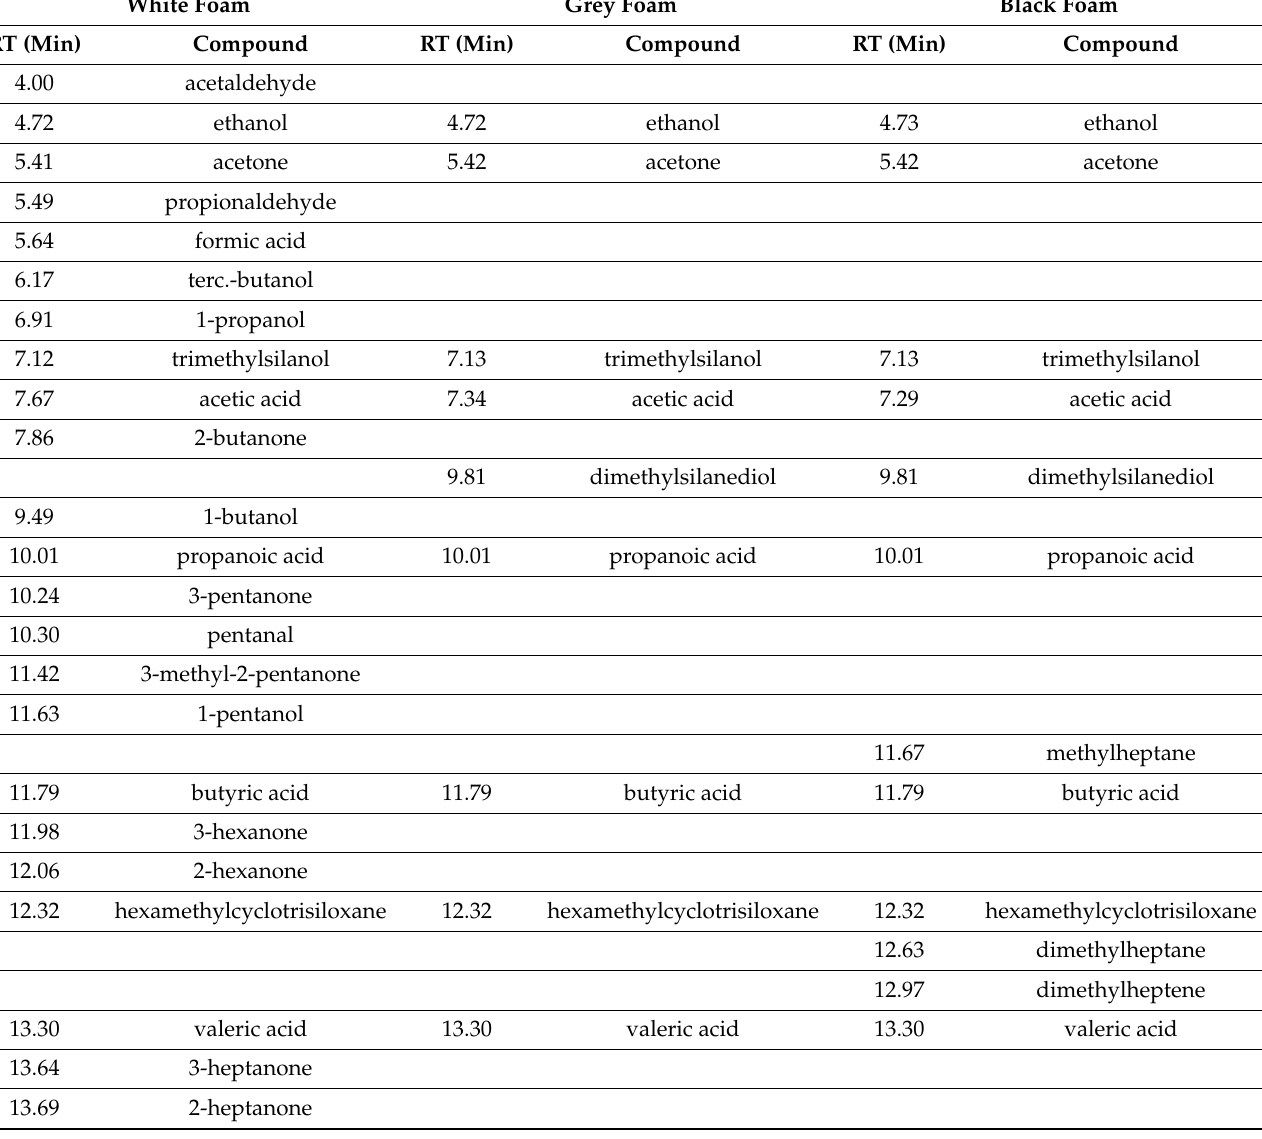
Table 3. Retention time (RT) and corresponding compounds detected for PE foams after artificial aging. Grey Foam Black